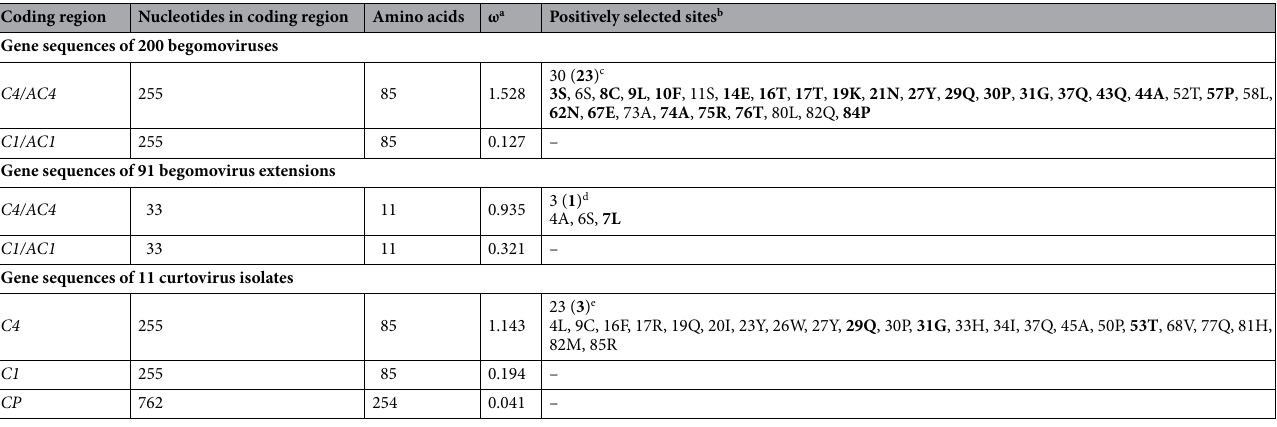
Table 1. Positive selection analyses of C4(AC4) or C1(AC1) gene sequences from begomovirus and curtovirus species. a Mean ratio of the nonsynonymous ( d N ) and the synonymous substitution rates ( d S ). ω < 1 represents purifying selection; ω = 1 neutral selection; and ω > 1 positive selection. b Number of amino acid sites under positive selection based on Bayes empirical Bayes analysis. Amino acid residue number and single letter amino acid designation having a posterior probability of P > 90% in regular font and of P ≥ 95% in bold font. c Amino acid positions and amino acids refer to HE616777 (African cassava mosaic Burkina Faso virus; ACMBFV). d Amino acid positions and amino acids refer to AJ851005 (Ageratum leaf curl virus; ALCuV). e Amino acid positions and amino acids refer to M24597 (Beet curly top virus; BCTV/CA/Logan).